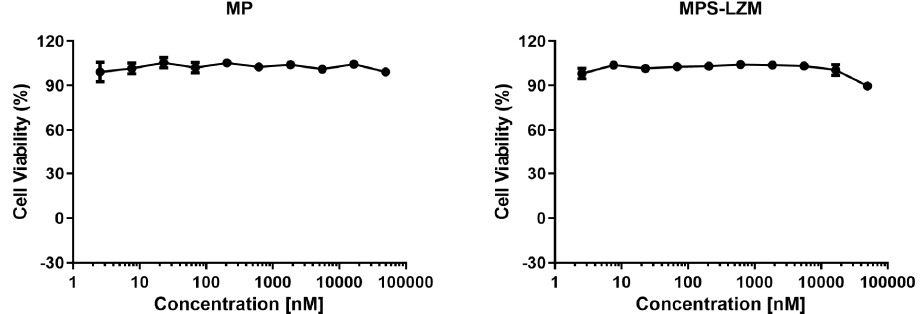
Figure 5. Cell viability of HK-2 cells after 24 h exposure to 0–50 µ M methylprednisolone (MP) and MPS–LZM. Untreated HK-2 cells were used as control and set at 100%. Error bars represent the standard deviation from duplicate determinations, and results are shown as mean ± SD. No obvious toxicity was observed for any of the evaluated compounds.